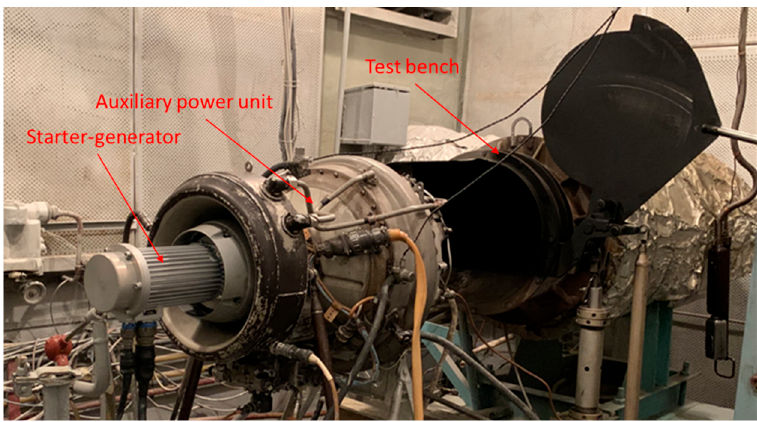
Figure 11. Starter-generator on the APU.